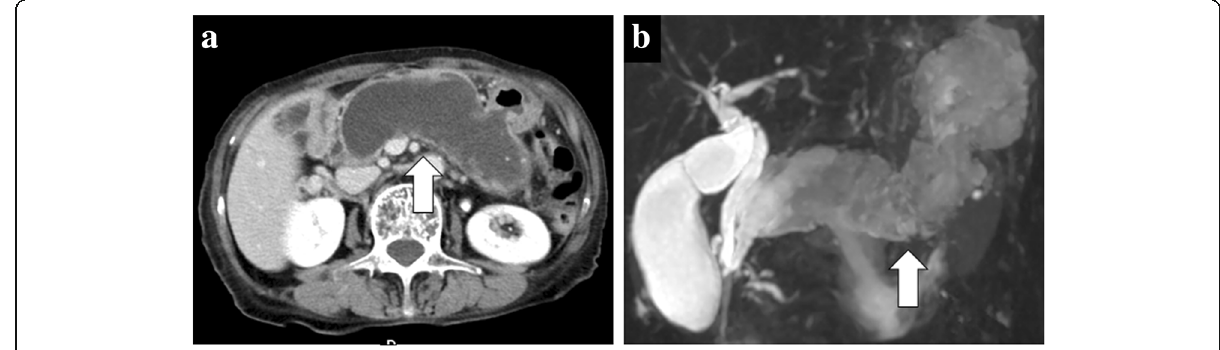
Fig. 1 Dilatation of the main pancreatic duct in the entire pancreas. a Contrast-enhanced computed tomography revealed a markedly dilated main pancreatic duct (55 mm) and thinning pancreatic tissue (white arrow). b Magnetic resonance cholangiography revealed main pancreatic duct dilatation (white